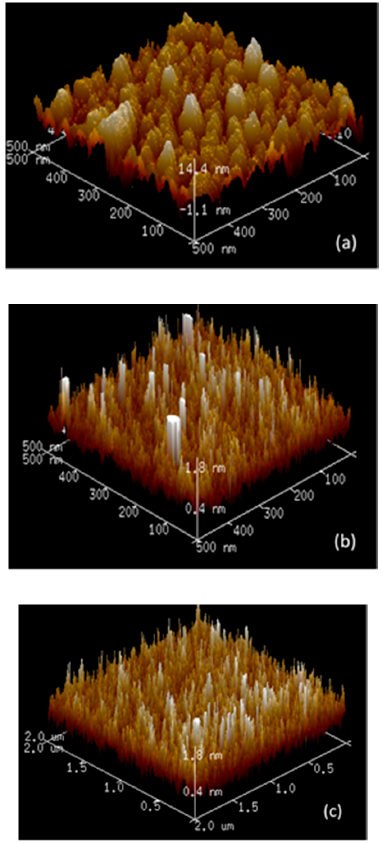
Figure 5. AFM images of ( a ) 6 nm Ag film with an RMS roughness of 3.99 nm, ( b ) 8.3 nm Ag:Al films with an RMS roughness of 0.47 nm, ( c ) 7.1 nm Ag:Al films with an RMS roughness of 0.37 nm.